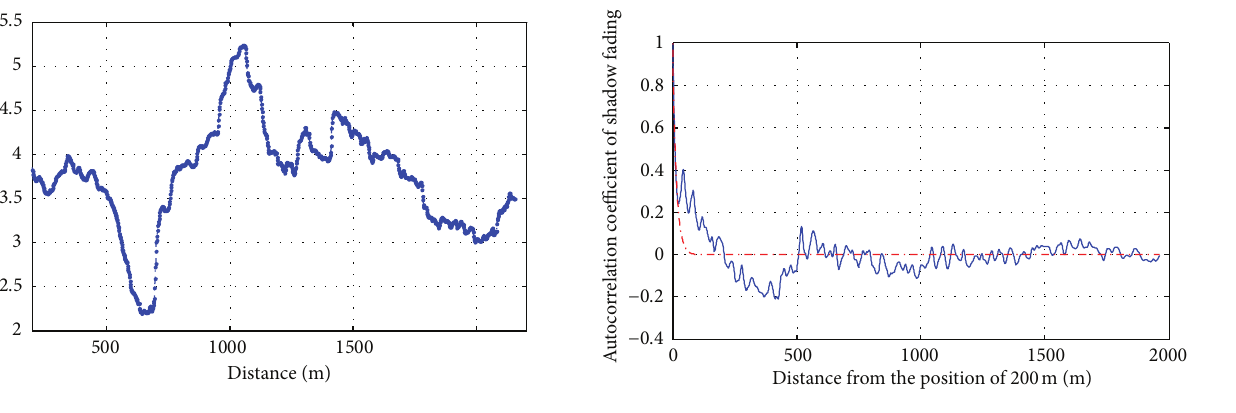
Figure 5: Standard deviation of shadow fading in hilly terrain.